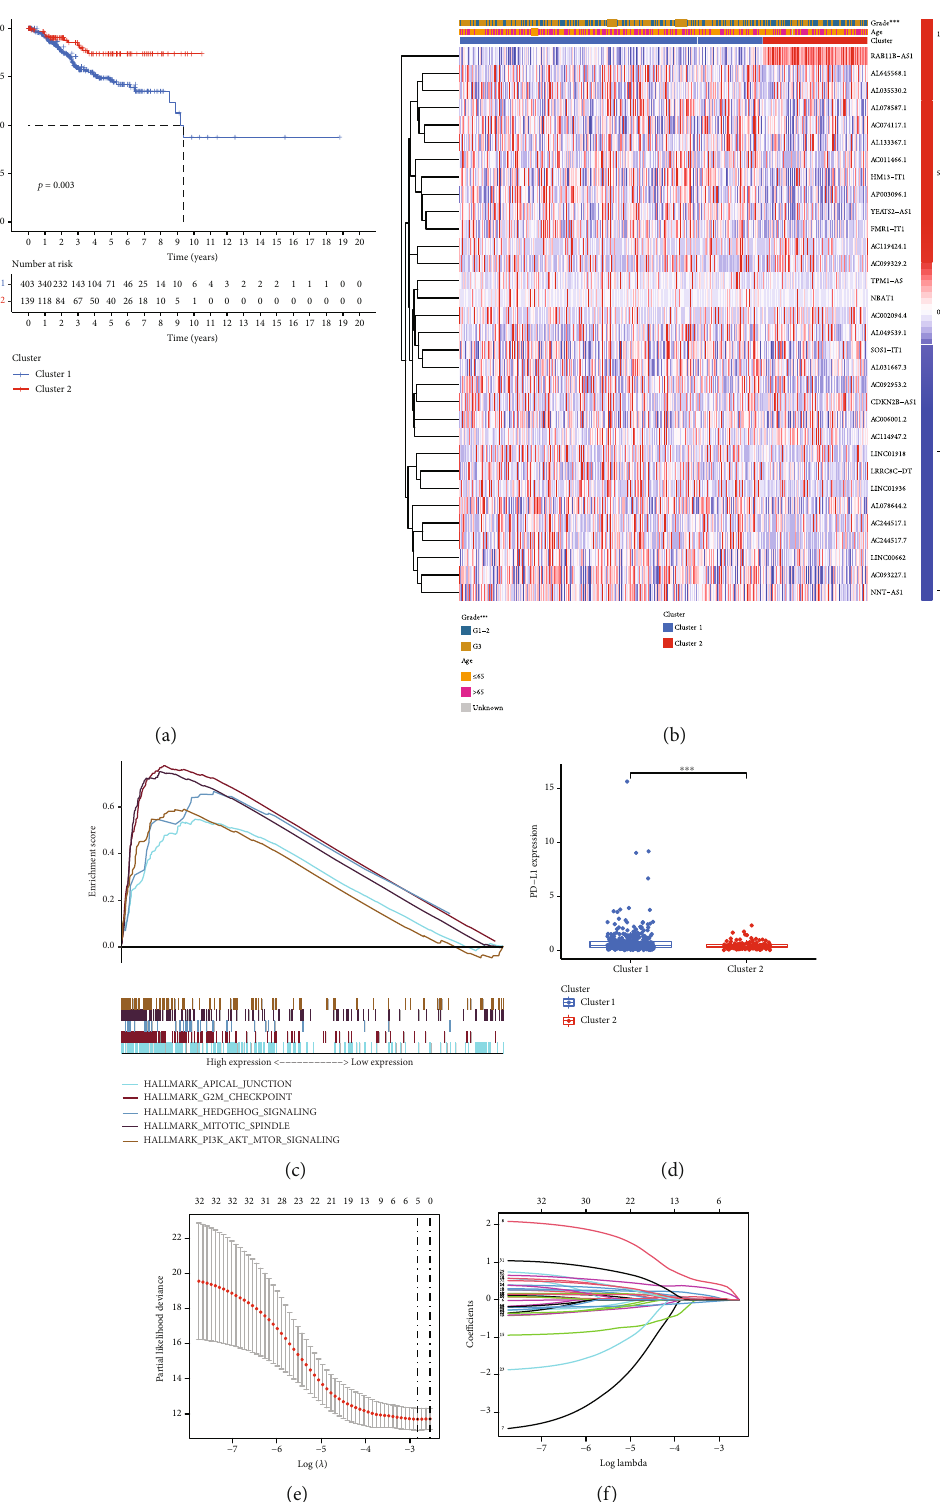
Figure 4: Variation of pathways, patient clinical characteristics, and prognosis among di ff erent clusters. (a) Kaplan – Meier overall survival curves of di ff erent clusters of uterine corpus endometrial carcinoma (UCEC) patients. (b) Expression of lncRNAs and clinical characteristics in di ff erent clusters of UCEC patients. (c) Pathways enriched in cluster 1 in comparison with cluster 2. (d) The expression of programmed cell death 1 ligand-1 (PD-L1) expression among di ff erent clusters of patients with UCEC. (e) Least absolute shrinkage and selection operator (LASSO) analysis. (f) LASSO coe ffi cient for nine m6A-relevant long noncoding RNAs. (b) Parameter selection and adjustment in the LASSO model by